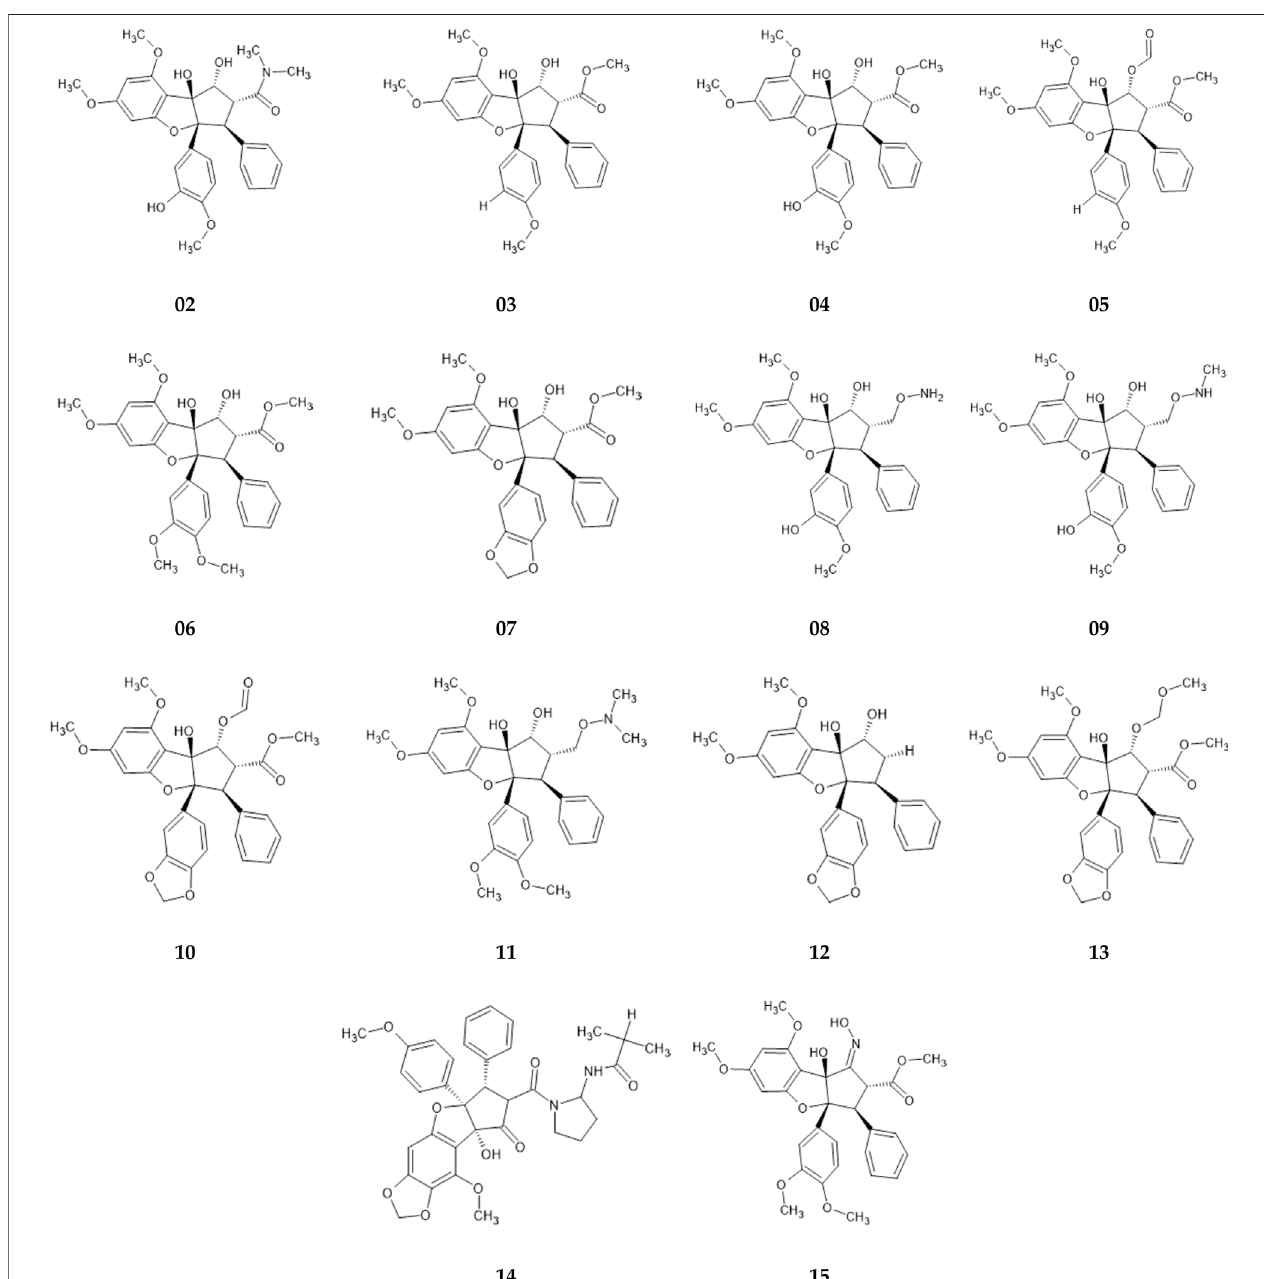
FIGURE 3 | Training set consisting of fourteen Roc-A derivatives, described by Nugroho et al. (1997), Nugroho et al. (1999), used to build pharmacophore models.